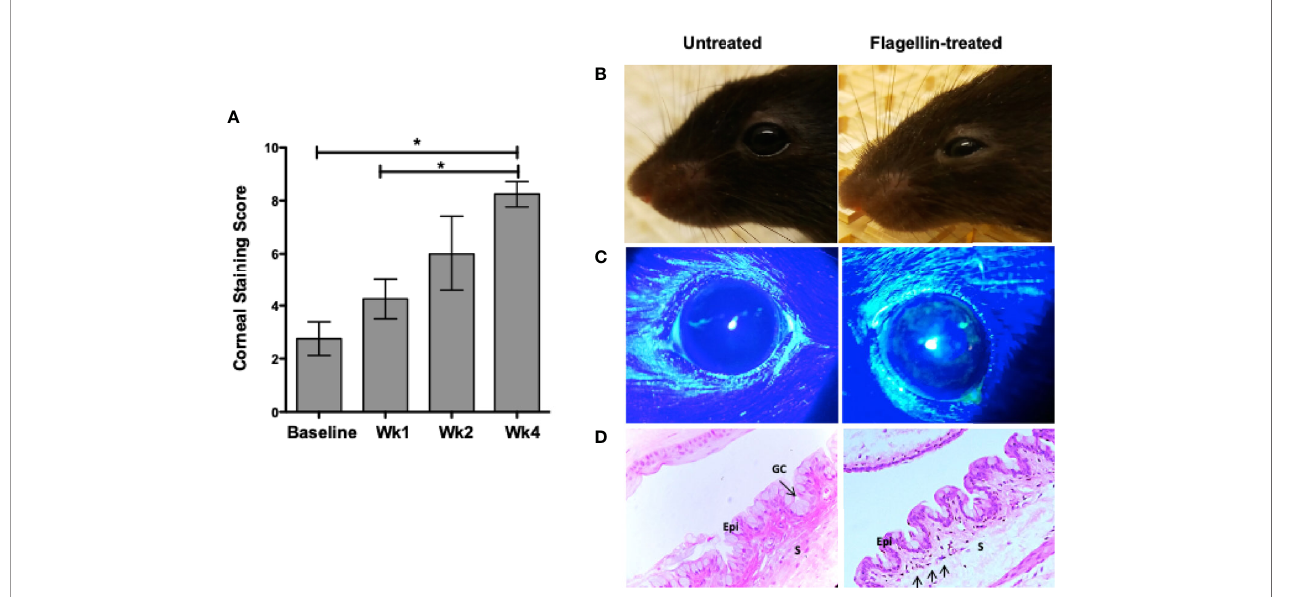
FIGURE 4 | Topical application of fl agellin results in chronic ocular surface in fl ammation. Flagellin (10 ng/day) was applied topically in C57BL/6 mice for 7 days. Development of ocular surface in fl ammation was monitored by assessing corneal barrier integrity, clinical signs, and conjunctiva histology. Corneas were evaluated for punctate epitheliopathy before and up to 4 weeks post- fl agellin application using 1% sodium fl uorescein application followed by slit lamp exam using cobalt blue light. Staining was scored according to standardized NEI grading system (A) . Representative photographs of untreated and fl agellin-treated mice (B) ; their corneal fl uorescein staining (C) ; and H&E-stained sections of conjunctiva at 4 weeks. (D) Epithelium (Epi), Stroma (S), and Goblet cells (GC) are marked, and arrows in the conjunctiva from fl agellin-treated mouse point to in fl ammatory in fi ltrates. Data expressed as mean ± SEM, n = 4, * p < 0.05 wk4 vs.